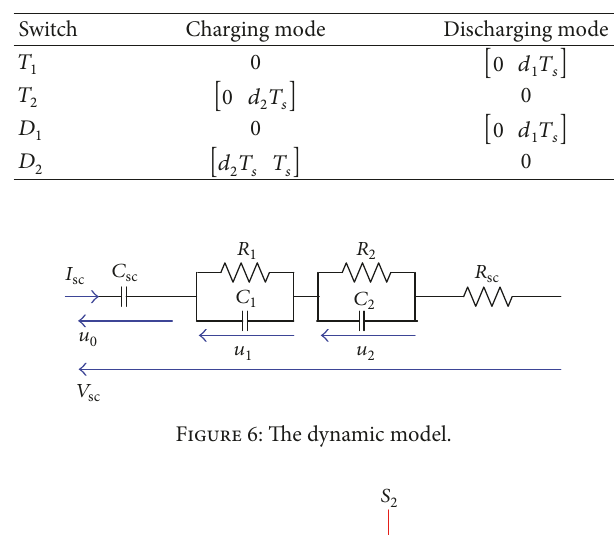
Table 1: State of the switches.